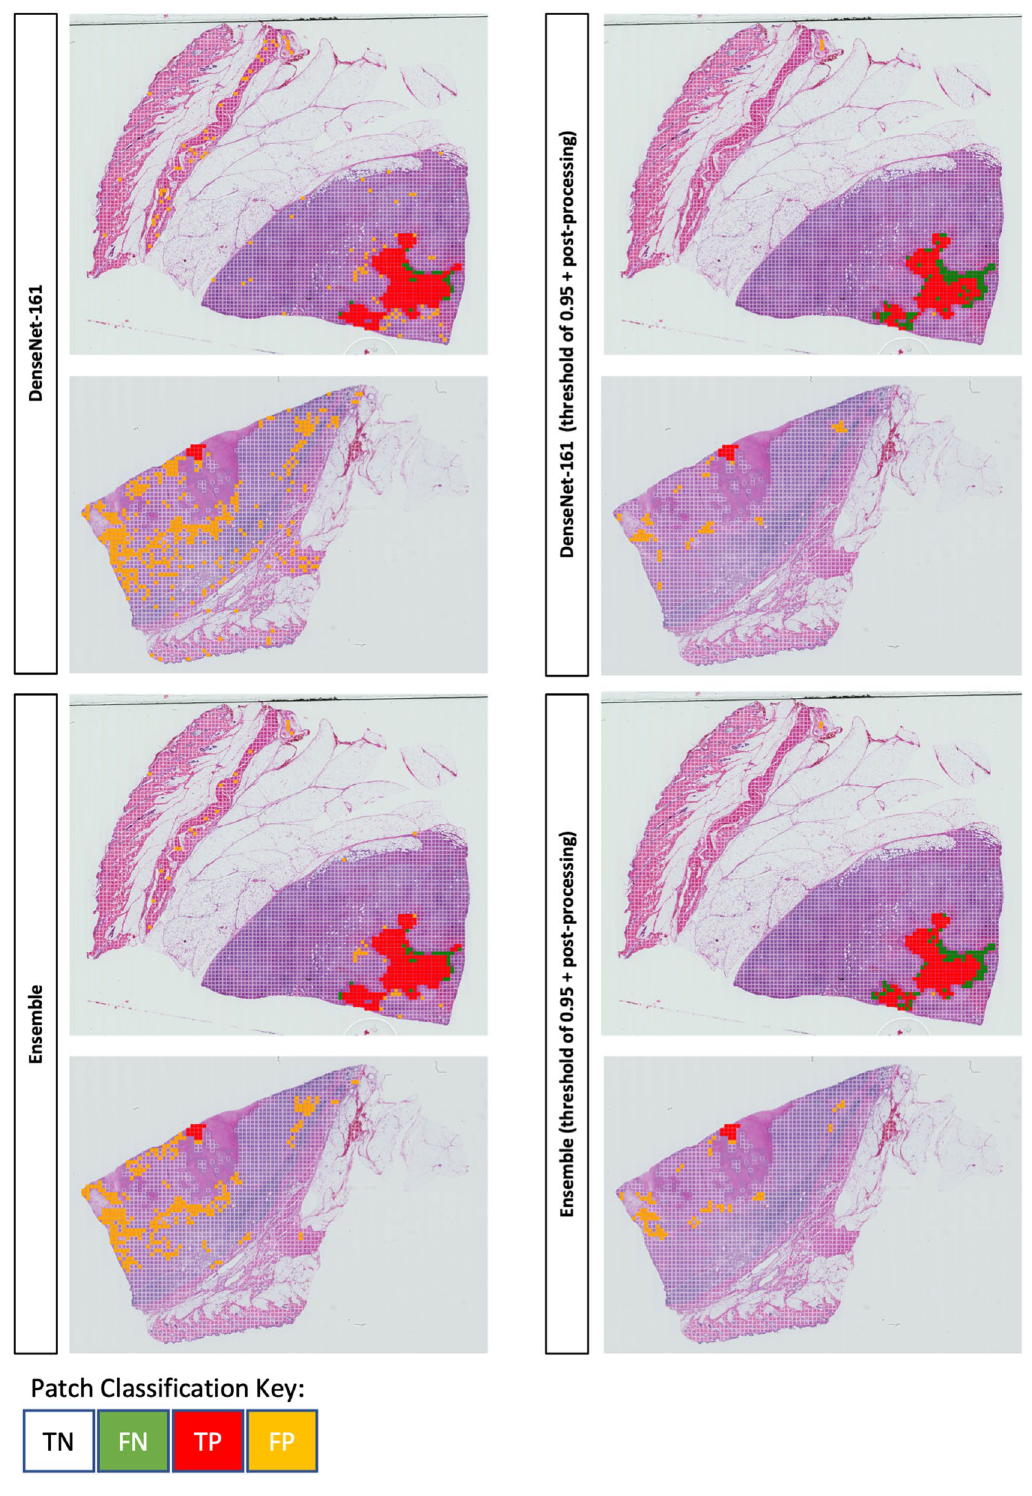
Figure 6. Sample Whole Slide Image (WSI) spatial confusion maps before and after applying optimal threshold (determined from the fold 3 validation set) and post-processing; removing single tile predictions. The left side images shows predictions from the DenseNet-161 and ensemble models with the standard 50% probability decision thresholds. The right side shows predictions after applying the optimal threshold and post-processing. True positives (TP) are displayed in red, false negatives (FN) in green, false positives (FP) in yellow and true negatives (TN) in